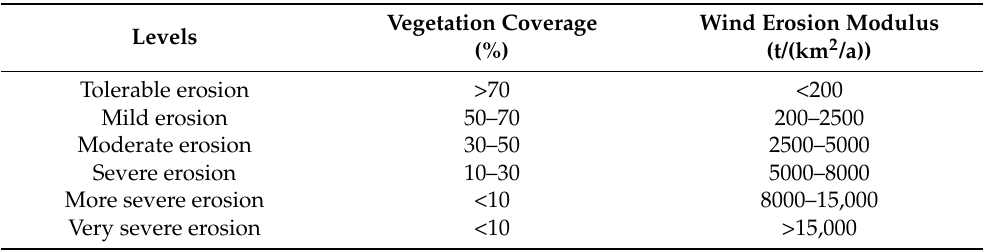
Table 2. Classification of the intensity of soil wind erosion in the TNR by the PRC Ministry of Water Resources (SL190 −